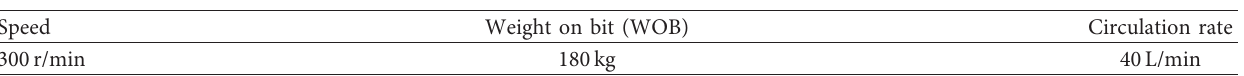
Table 5: Drilling